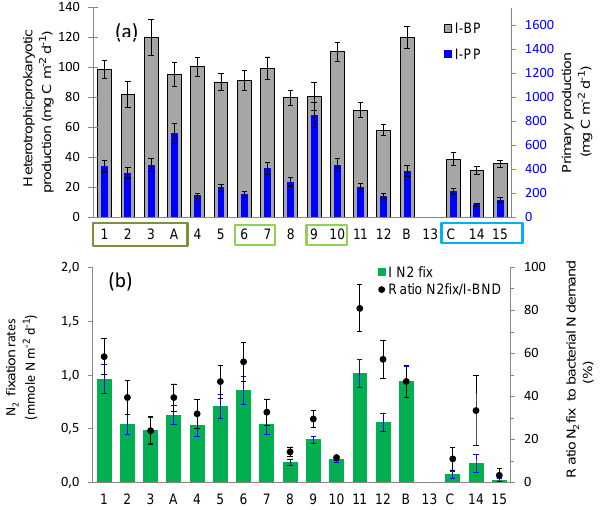
Figure 3. (a) Distribution of integrated heterotrophic prokaryotic production (IBP) and primary production (IPP deck ) along the tran- sect, data were integrated over the euphotic zone. WMA (dark green), EMA (light green) and WGY (blue) stations are noted by colored rectangles. (b) Distribution of integrated N 2 fixation rates and of ratio N 2 fixation rates to bacterial nitrogen demand (I N 2 fix/I-BND, assuming a bacterial C / N ratio of 5 and no nitro- gen excretion) along the transect. Data were integrated down to the deepest sampled depth for N 2 fixation rates. Data plotted for sites LDA, LDB and LDC correspond to BP, PP deck and N 2 fix measured on day 5. Error bars are standard errors (SE) derived from triplicate measurements at each depth (BP, PP deck , N 2 fix rates). For BP, error bars also take into account the daily variability, and final SE were calculated after propagation of errors. PP obtained at SD13 was ab- normally low (55mg Cm − 2 d − 1 ) and was excluded; BP and N 2 fix rates were not measured at this